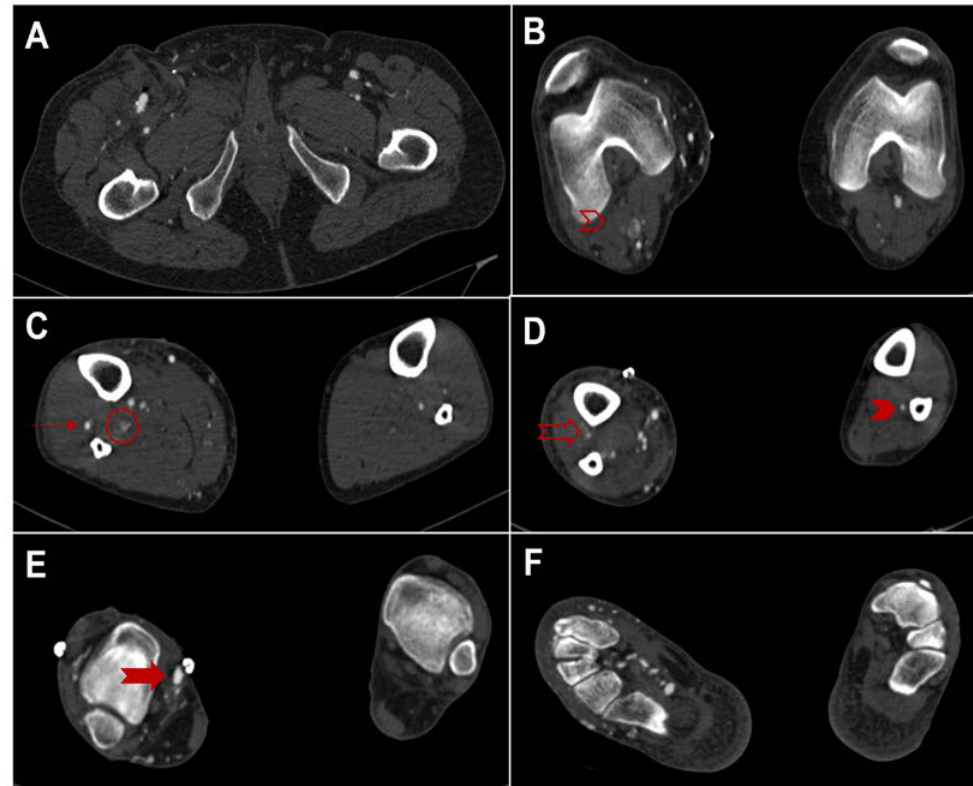
Figure 2. Computed tomography angiography (Siemens Somatom Definition AS, Siemens Healthcare, Erlangen, Germany) on axial planes (from top to bottom) after open deep vein arterialization. ( A ), on the right side, patent proximal anastomosis between the great saphenous vein and the superficial femoral artery. ( B ), occlusion of the right peroneal artery (empty red right arrowhead). ( C ), on the right side, patent proximal anterior tibial artery (red arrow) and occlusion of poster tibial and peroneal arteries (red circle). ( D ), occlusion also of the right distal anterior tibial artery; on the left side note the patency of the peroneal artery alone (full red arrowhead). ( E ), on the right side, patent distal anastomosis between the great saphenous vein and posterior tibial vein (full red arrow) ( F ), on the right side note the enhancement and ectasia of the plantar venous circles, related to the presence of arteriovenous bypass, while on the left side no vessel is enhanced.